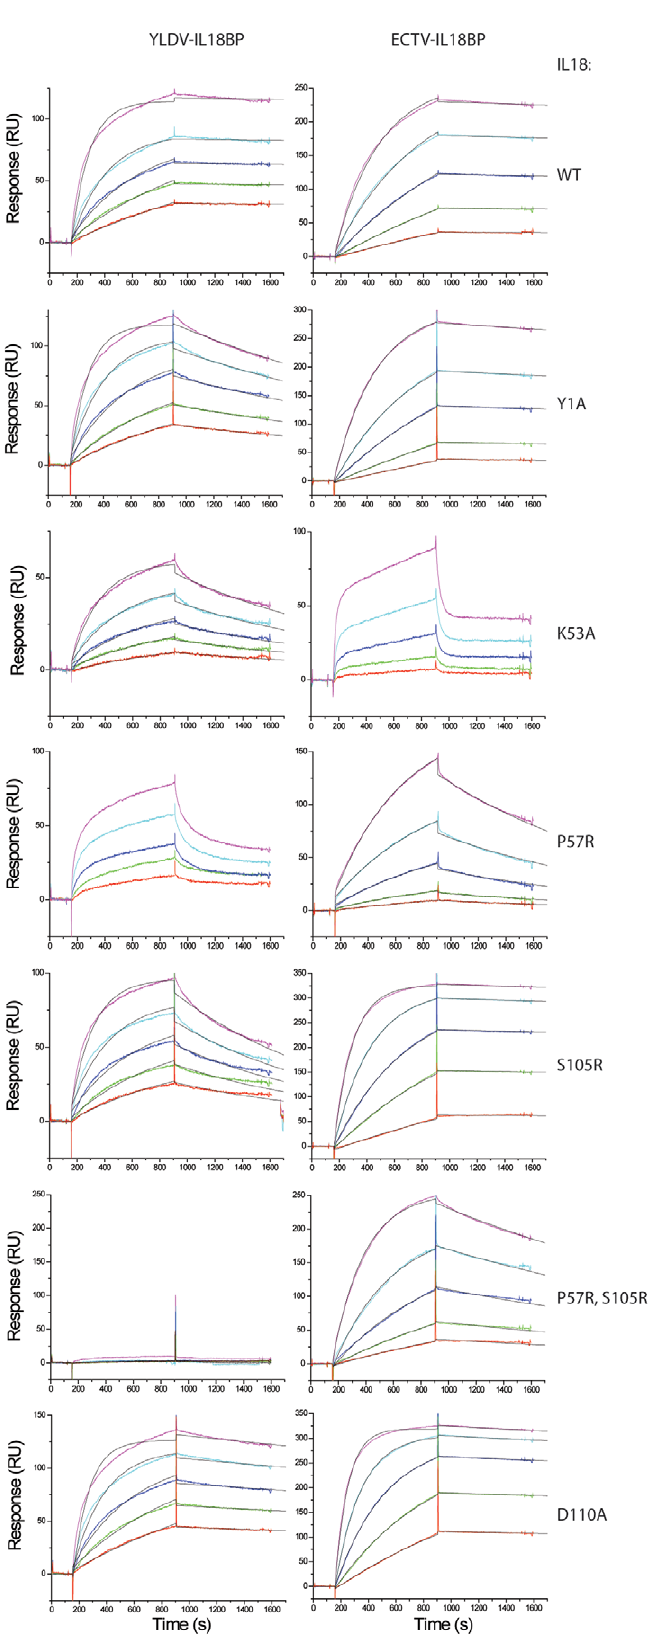
Figure 10. Kinetic analyses of the binding of IL18 with YLDV-IL18BP or ECTV-IL18BP. SPR analysis was performed as described in Figure 9 with IL18 at 5 different concentrations. The binding curves were globally fitted with BiaEvaluation software to a 1:1 binding model. The colored and black lines are the actual responses in RU and globally fitted curves, respectively. doi:10.1371/journal.ppat.1002876.g010 PLOS Pathogens |